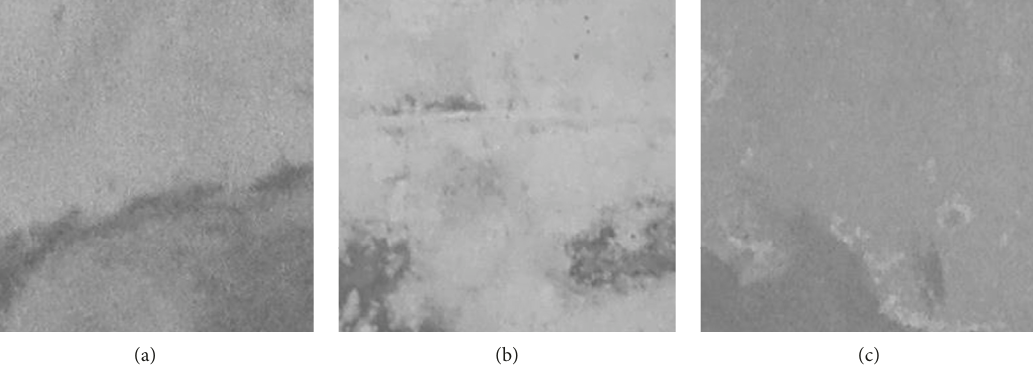
Figure 3: Concrete surface color-difference images.